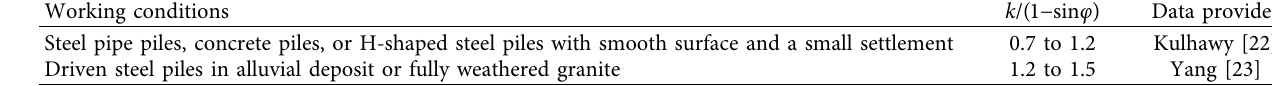
Table 1: Suggested value of the lateral Earth pressure coefficient k .